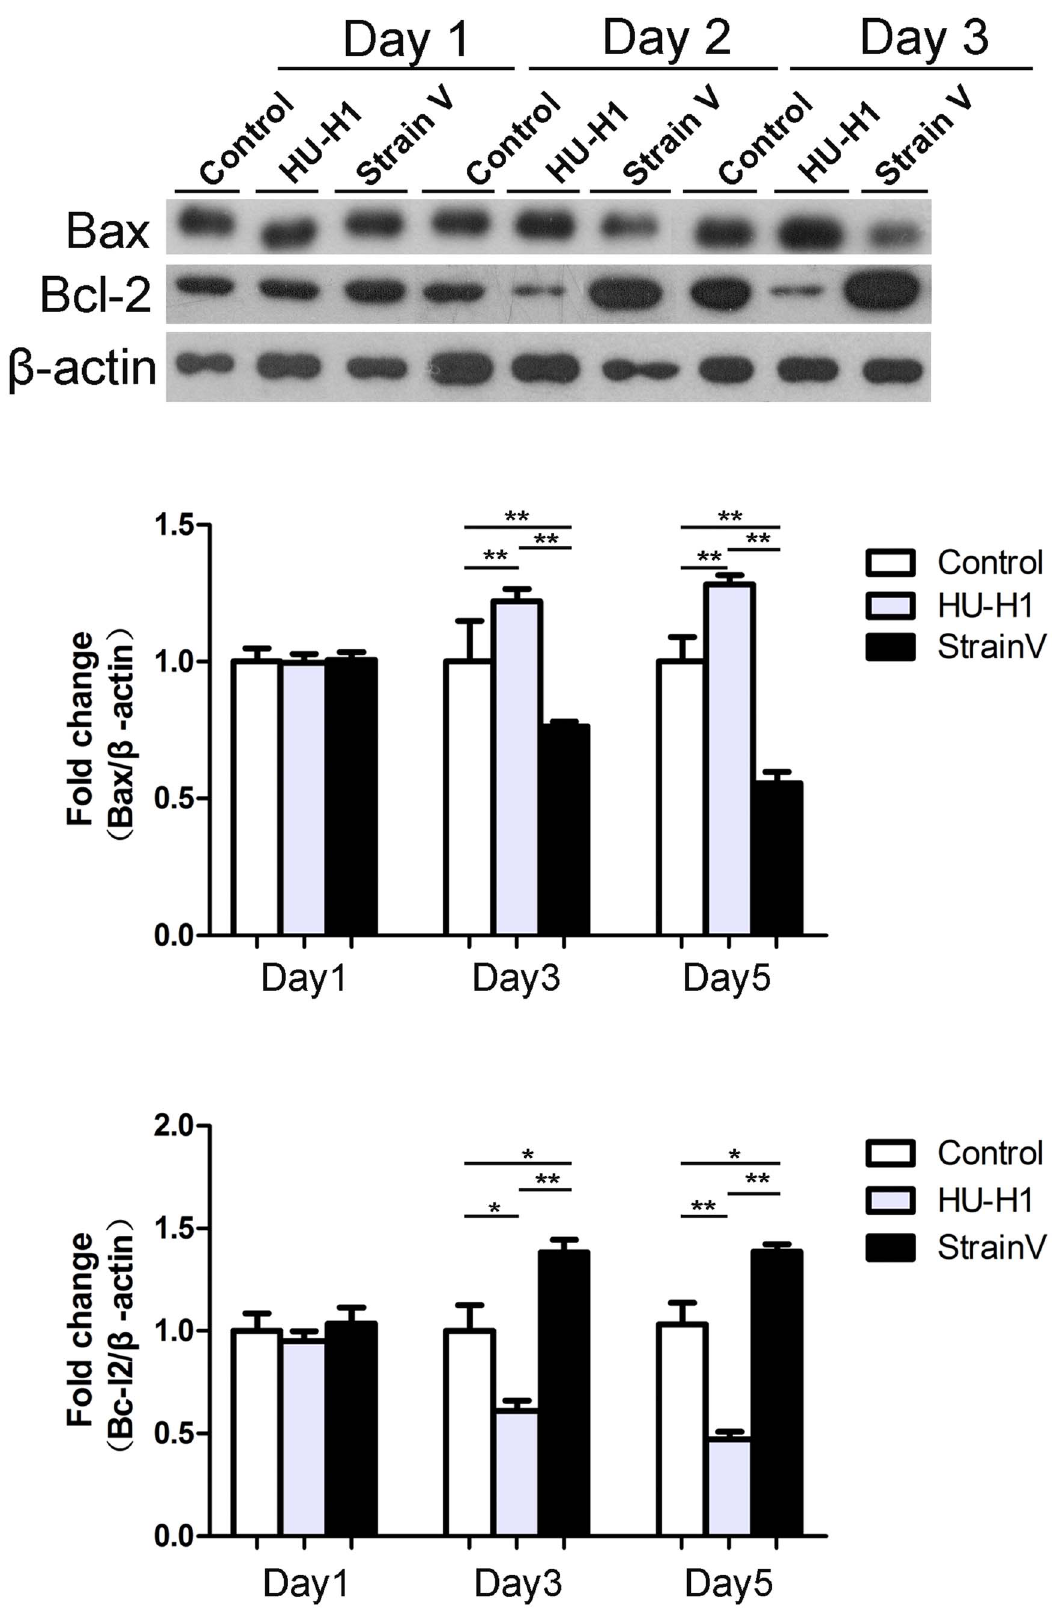
Figure 7. Bax and Bcl-2 expression in Hu-H1, Strain V, and control cells. * p , 0.05 ; ** p , 0.05.